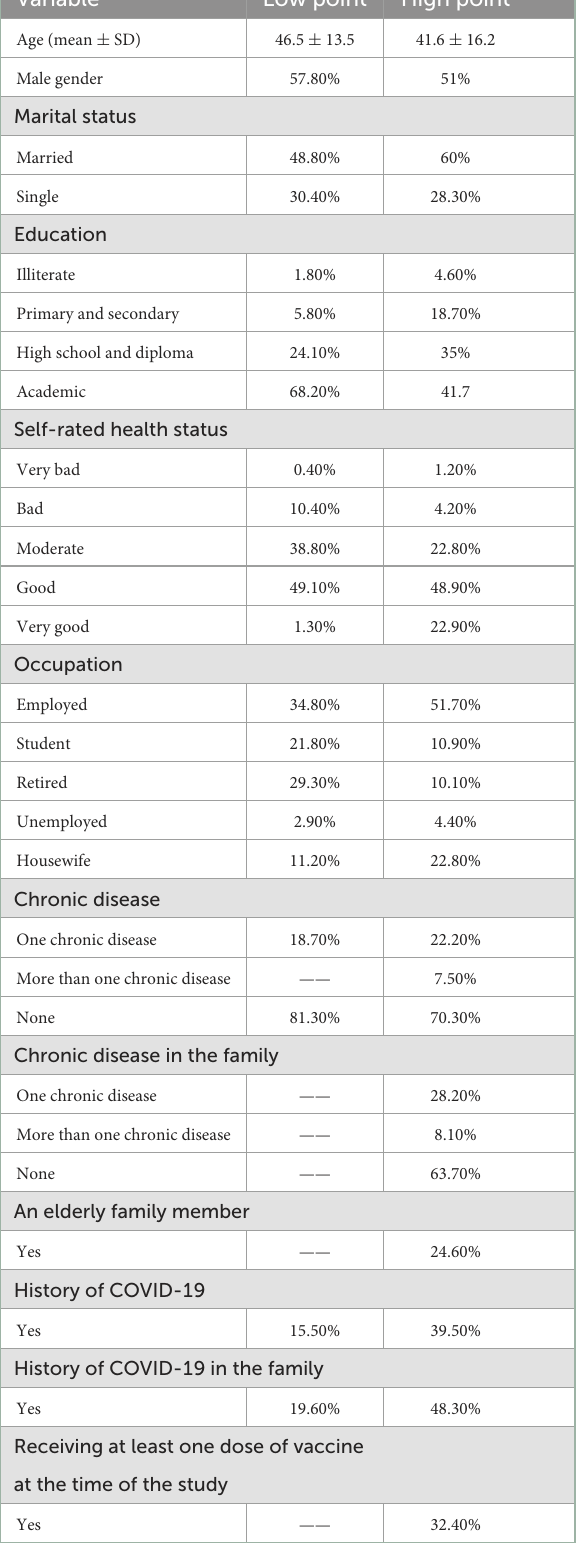
TABLE 2 Baseline characteristics of participants at the low and high